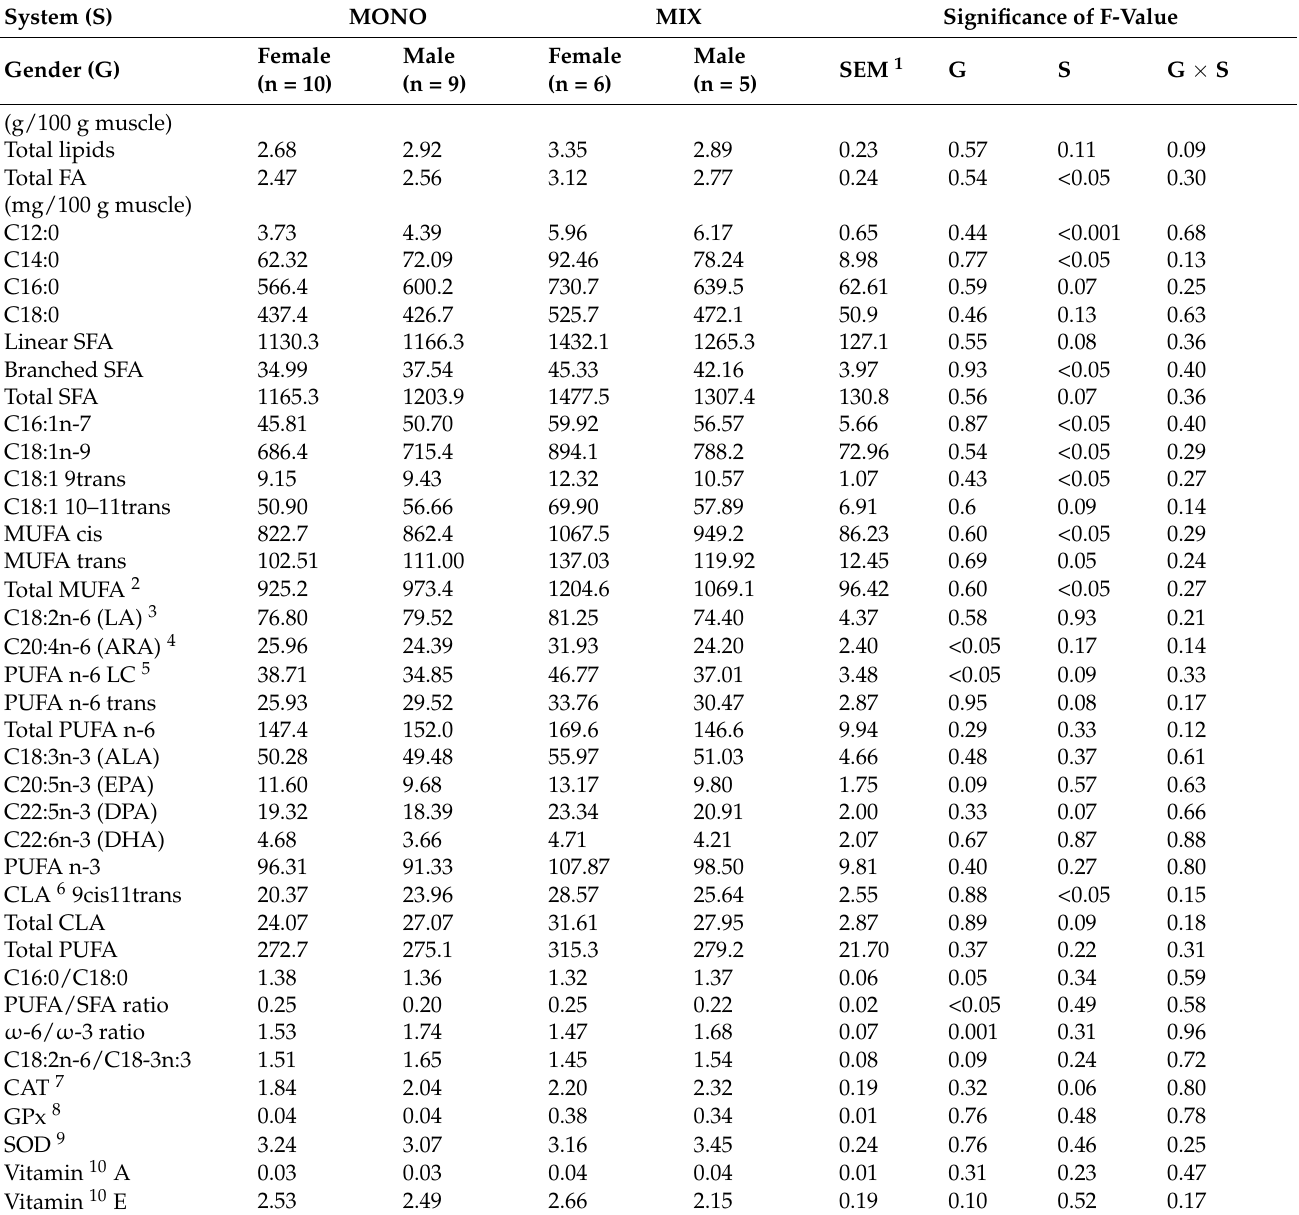
Table 3. Estimated marginal means of FA content, antioxidant content, and vitamin content as affected by animal gender and farming